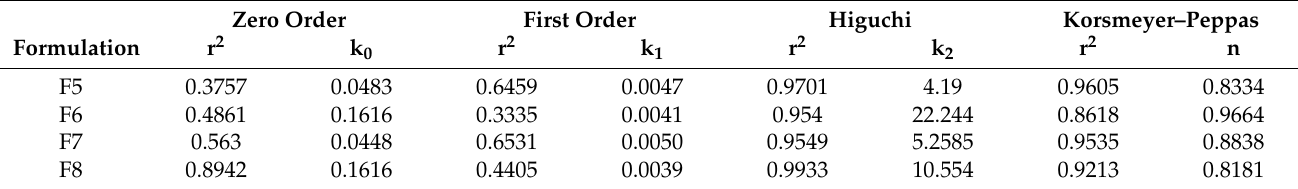
Table 2. In vitro drug-release kinetic study for